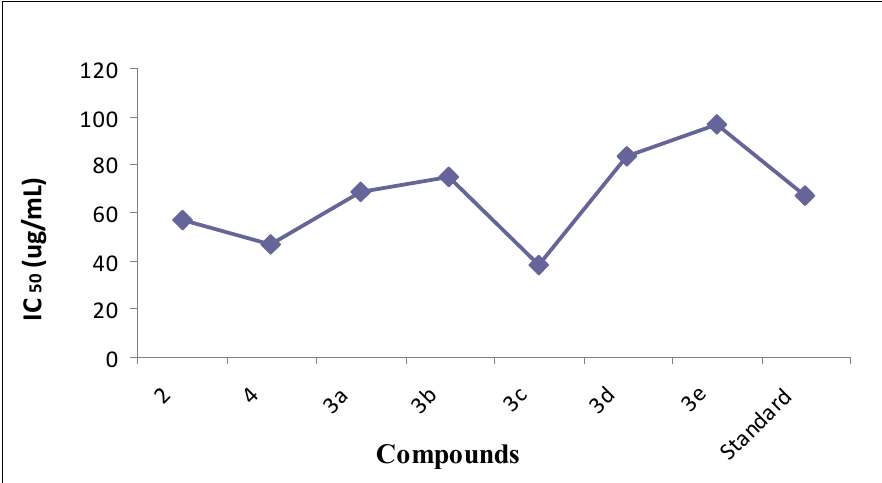
values of compounds 2 , 3a – e , 4 50